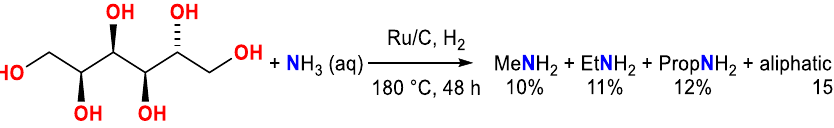
Table 8. Catalytic amination of unprotected carbohydrates.